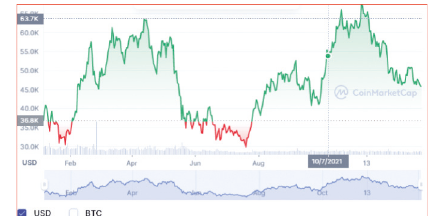
Table 5: Decision matrix for cryptocurrency market.